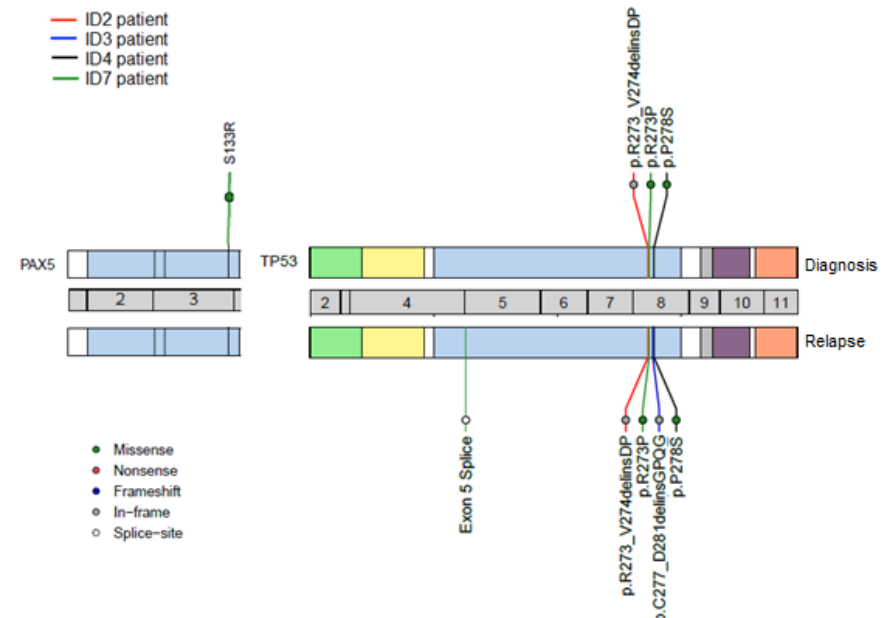
Figure 4. Mutations identified by next-generation sequencing (NGS) showed patterns of genetic evolution in paired diagnostic / relapse samples. Patient ID2 (red line) and Patient ID4 (black line): retained mutations in the TP53 gene. Patient ID7 (green line): retained one mutation in the TP53 gene, acquired a new mutation in the TP53 gene and lost one mutation in the PAX5 gene at relapse. Patient ID3 (blue line): acquired a new mutation in the TP53 gene at